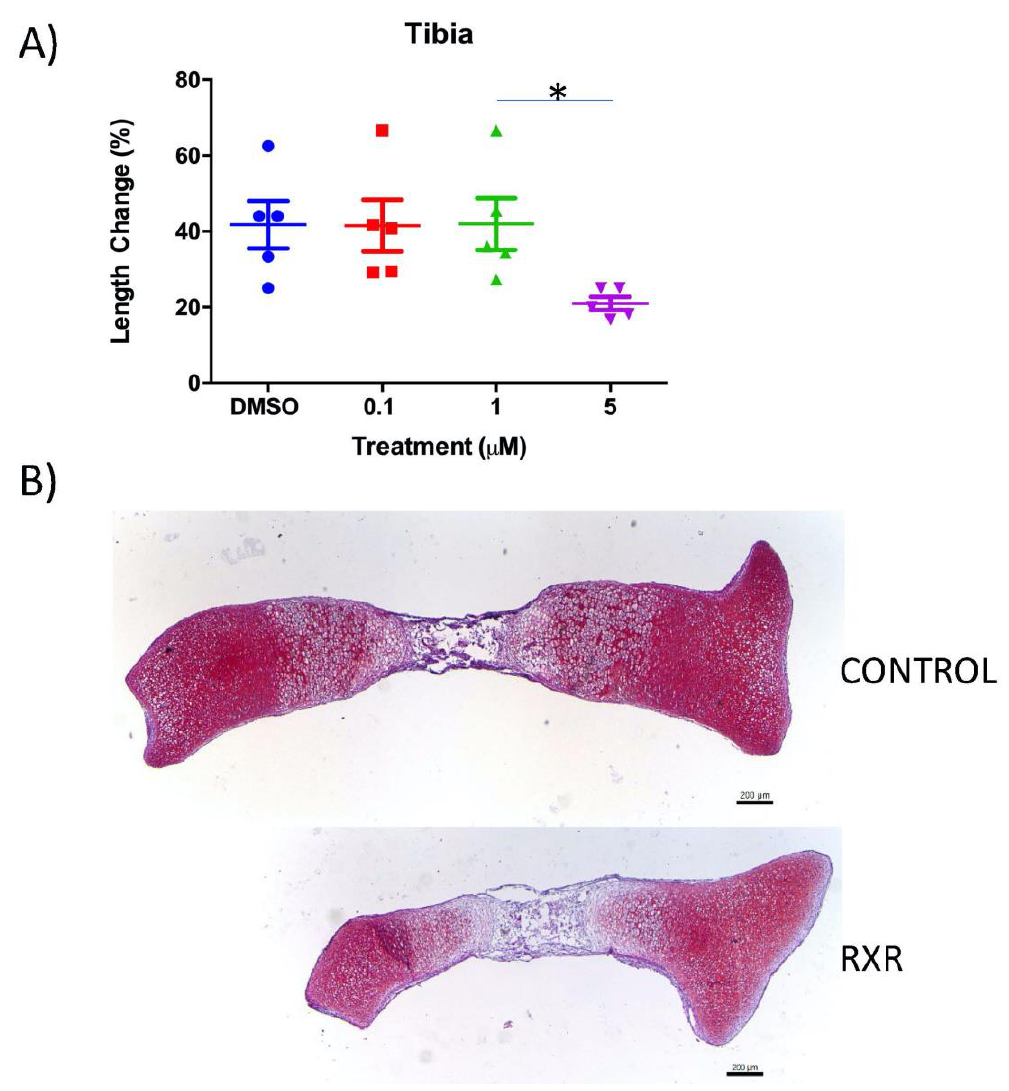
Figure 2. The RXR agonist SR 11237 decreases bone growth in murine tibiae in vitro. P0 tibiae were isolated and cultured for 4 days with DMSO and various concentrations of SR11237. The total length of bones was measured following isolation and upon experimental completion to determine the percentage of longitudinal growth. Treatment of tibia with 5 μM SR11237 caused a decrease in growth compare to all other conditions, but significance was only observed in comparison to the 1 μM treatment ( A ) ( N = 5; mean ± SEM; Kruskal–Wallis one-way ANOVA with Dunn’s post-hoc test; * p < 0.005). The DMSO -treated tibia (top) is trending to be longer than the tibia treated with 5 μM SR11237 (bottom) ( B ).